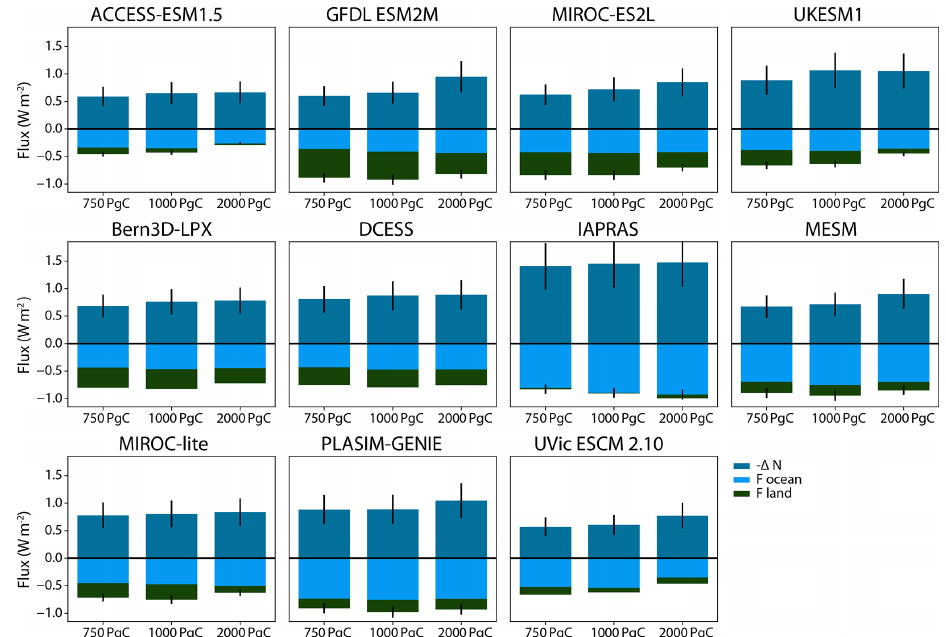
Figure 10. Energy fluxes following cessation of CO 2 emissions for the type A experiments (1%) for each model. (cid:49)N is the change in ocean heat uptake relative to the time that emissions ceased. A reduction in ocean heat uptake will cause climate warming, hence − (cid:49)N is displayed. F ocean is the change in radiative forcing caused by ocean carbon uptake, and F land is the change in radiative forcing caused by terrestrial carbon uptake. All fluxes are computed for averages from 40 to 59 years after emissions